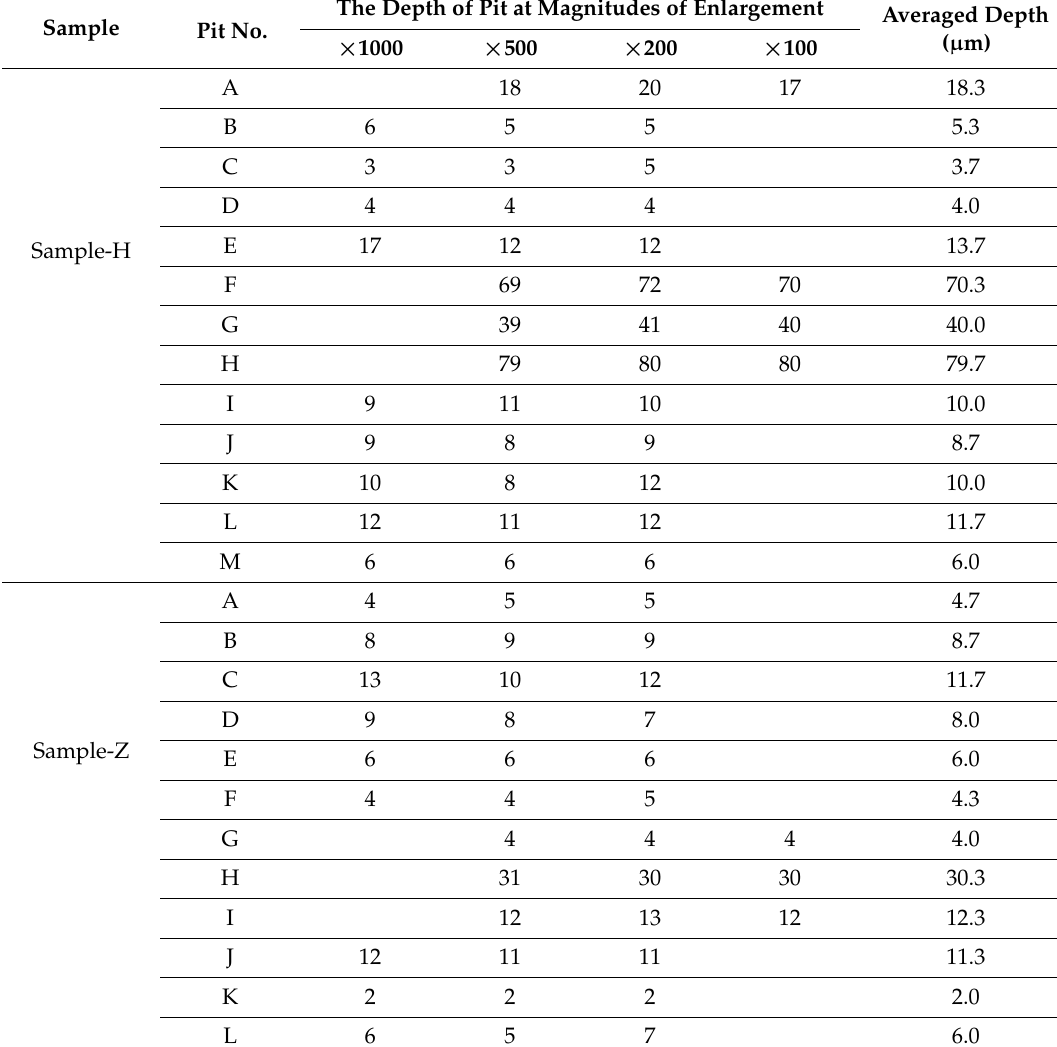
Table 2. Depth of pits measured by optical